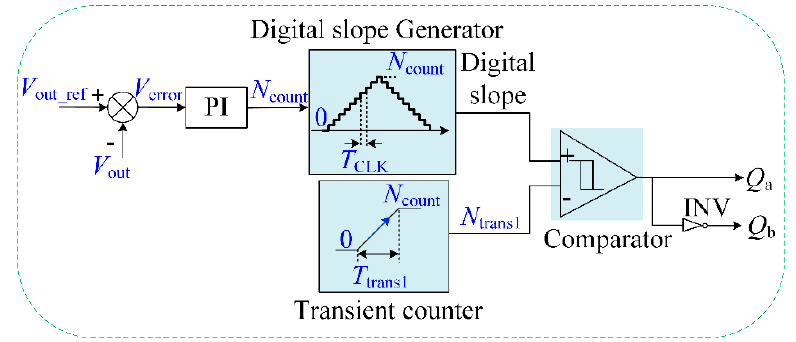
Figure 6. Digital implementation block diagram for transient switching process a.